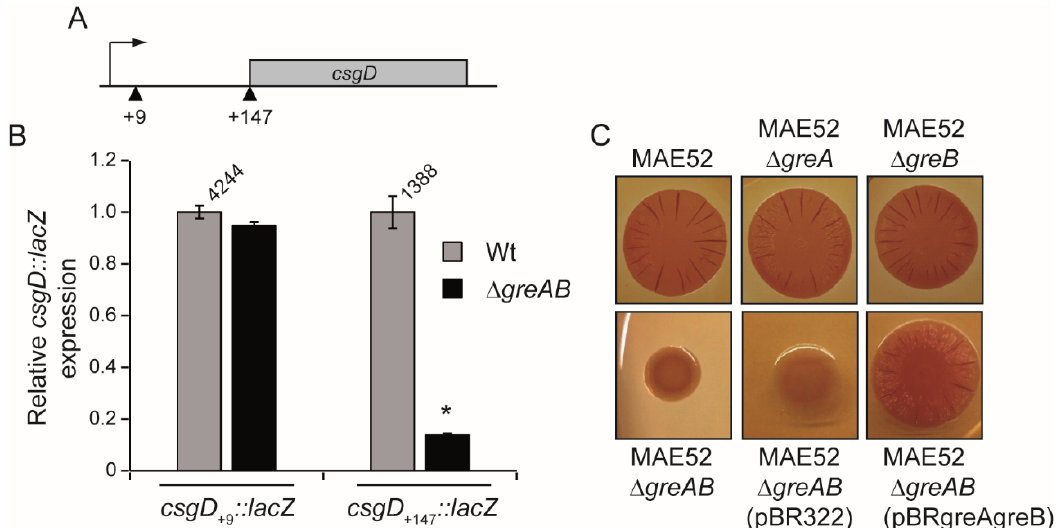
Figure 4. The 5 ′ UTR of the csgD gene is the target of the Gre factors. ( A ). Schematic representation of the generated chromosomal csgD::lacZ fusion: the csgD +9 ::lacZ lacks the 5 ′ -UTR and csgD +147 ::lacZ carries the 5 ′ -UTR. Arrowheads indicate the relative position of the gene fusions. ( B ). Relative expression of csgD in Wt and Δ greAB in the absence ( csgD +9 ::lacZ ) and presence ( csgD +147 ::lacZ ) of the 5 ′ UTR. Cultures were grown on LB 0 plates and incubated at 28 °C for 24 h. A bar shows the arithmetic mean of experimental results and the error bar indicates the standard deviation from three biological replicates. The mean in Miller unit is indicated for the Wt. Statistical significance to Wt is shown by an asterisk ( p < 0.0005). ( C ). Colony morphotype of strain MAE52 and its derivatives on Congo red agar plate. Plates were incubated at 28 °C for 24 h.